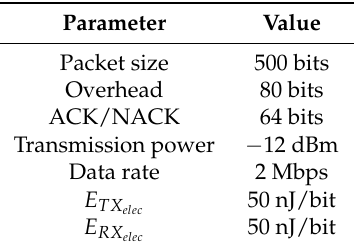
Table 3. Simulation parameters. NACK, non-ACK.